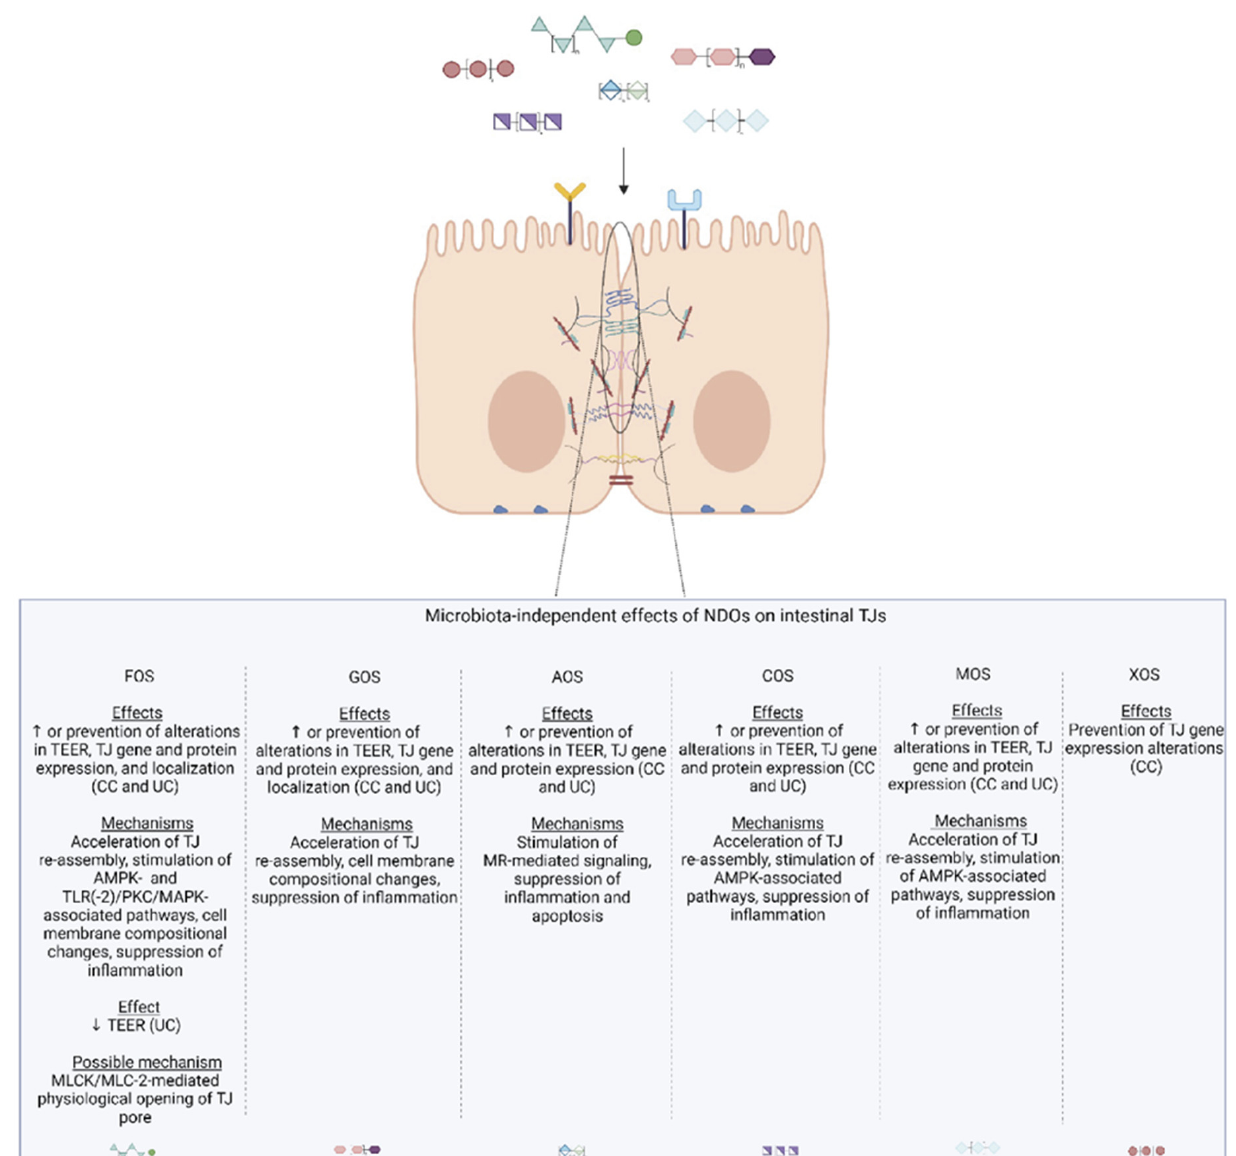
Figure 9. Synopsis of the NDO-mediated microbiota-independent effects on TJs: Apart from their prebiotic-associated barrier reinforcement, the NDOs interact with cell surface receptors including TLR, CaSR, and MR, positively modulating TJ functionality. NDOs can strengthen and protect the epithelial barrier integrity under normal and pathological conditions, preventing alterations in TJ expression and localization induced by injurious stimuli. These effects can be mediated by stimulation of TJ-regulatory effectors such as AMPK, PKC, and MAPK or by suppressing inflammatory and apoptotic pathways upon direct regulation of IECs and immune cells. CC: challenged conditions: treatment with NDO + a trigger; UC: unchallenged conditions: treatment with NDO solely. Created with BioRender.com. AMPK, Adenosine monophosphate-activated protein kinase; CaSR, Calcium- sensing receptor; MAPK, Mitogen-activated protein kinases; MR, Mannose receptor; NDO, Non- digestible oligosaccharide; PKC, Protein kinase C; TJ, Tight junctions; TLR, Toll-like